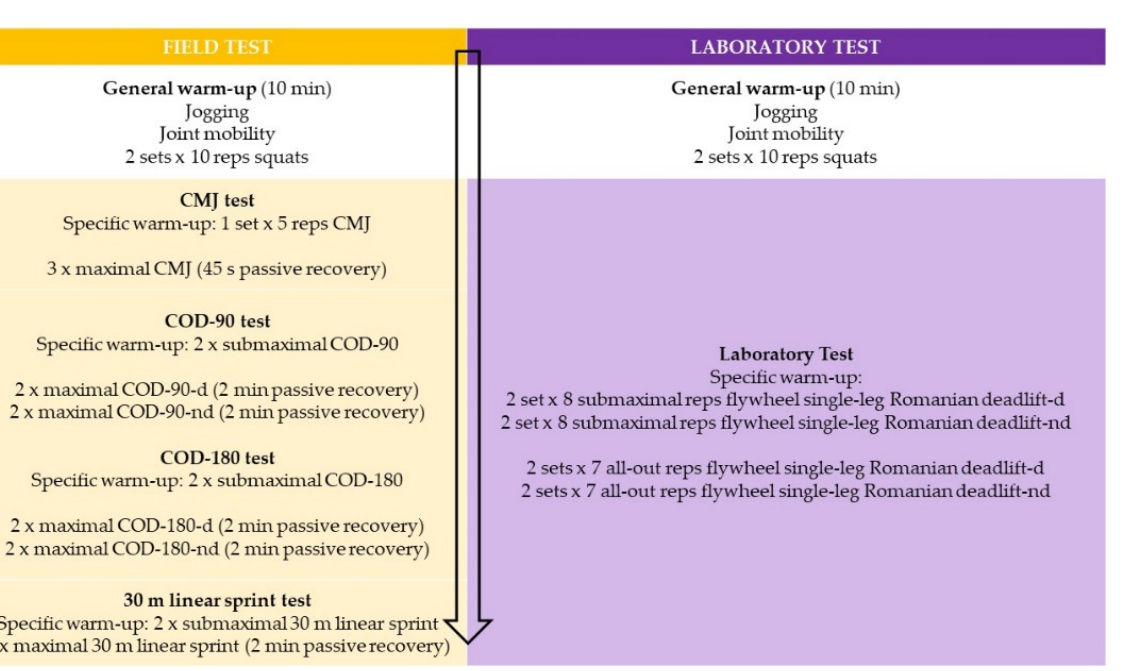
Figure 2. Field and laboratory testing protocols employed to evaluate effects of flywheel training.